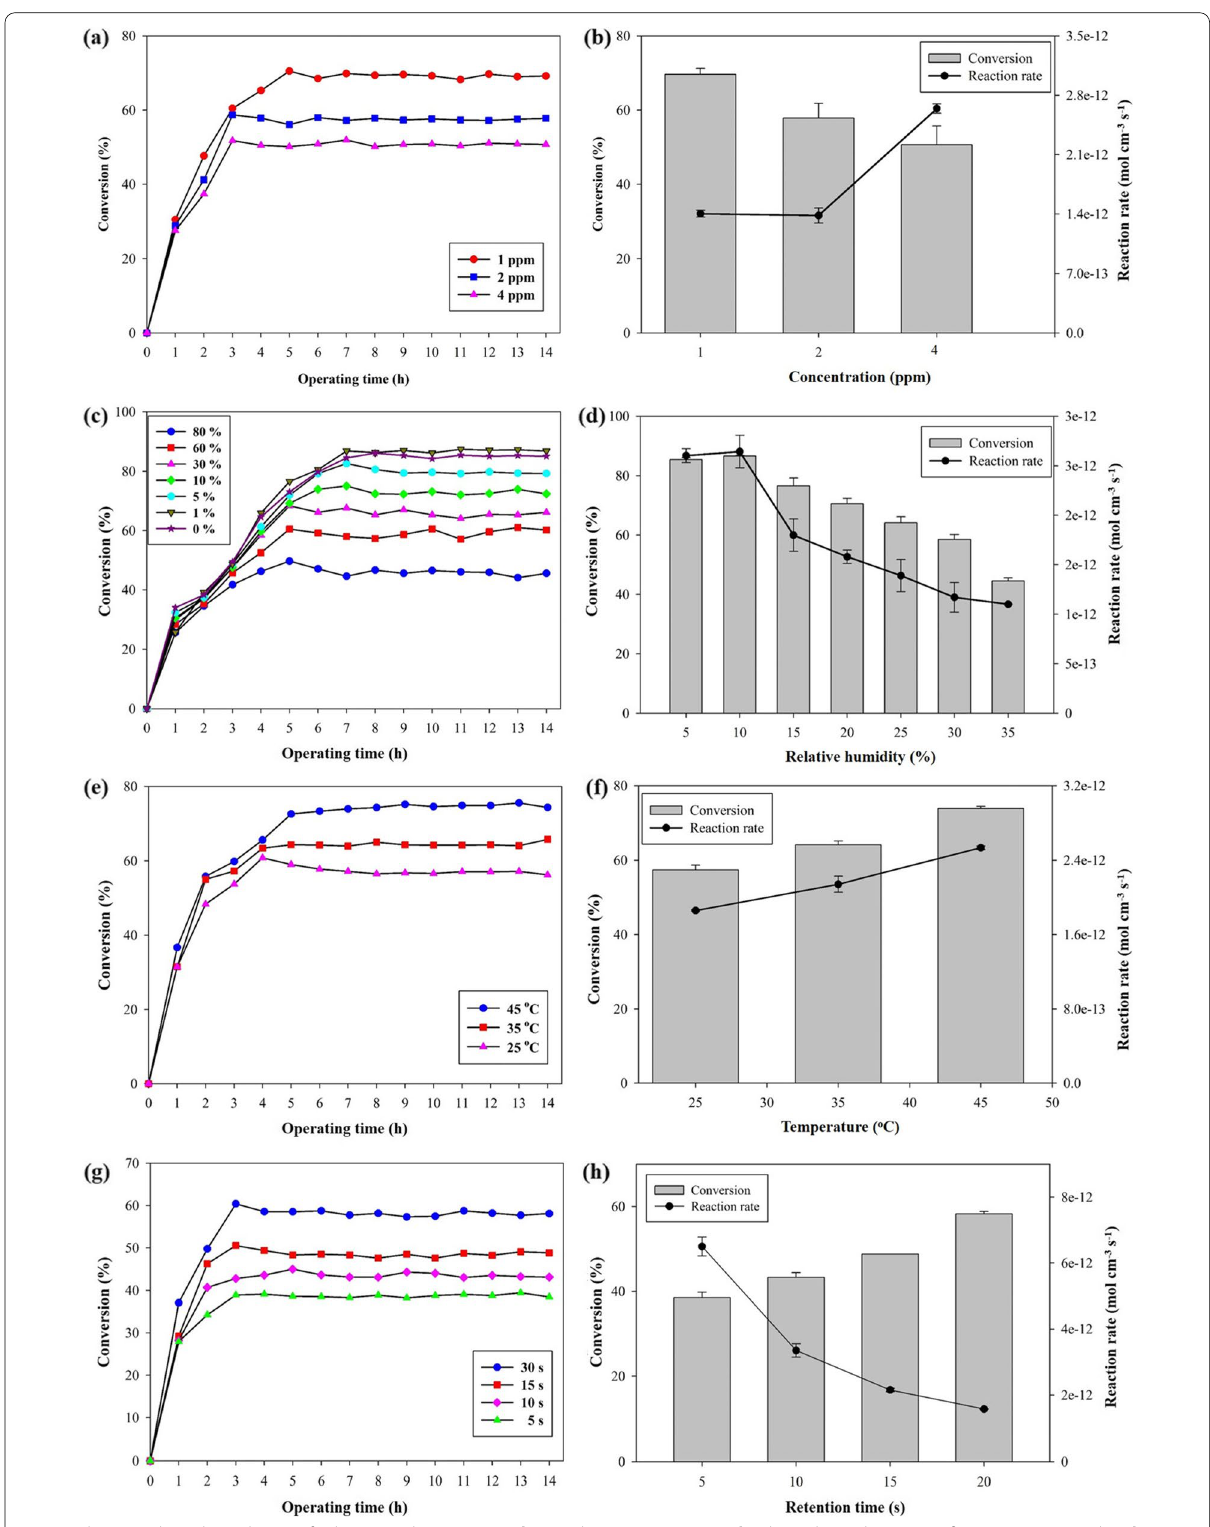
Fig. 7 Photocatalytic degradation of toluene under various ( a , b ) initial concentration, ( c , d ) relative humidity/RH, ( e , f ) temperature, and ( g , h ) retention